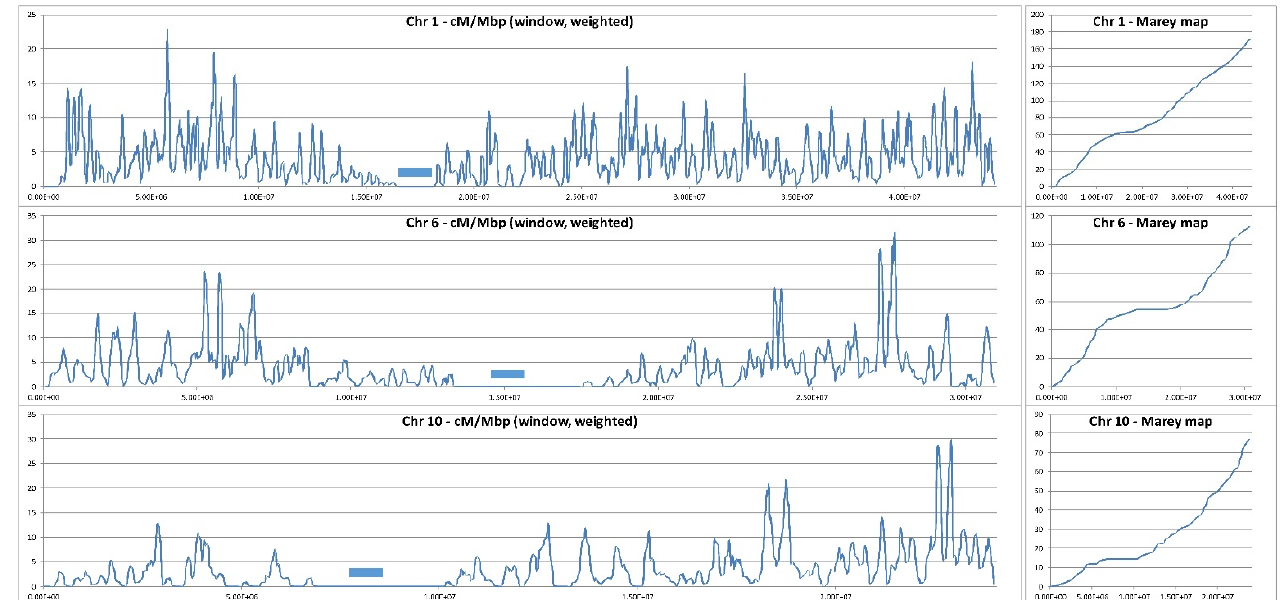
Figure 1. Local recombination rate along three representative chromosomes of rice. Cross-over positions have been deduced from low coverage (4x) Illumina reads of 380 F2 progeny plants derived from selfing of an indica/japonica hybrid. X axis: chromosome coordinates (Kitaake genome) in base pairs. Y axis: local recombination fraction in centiMorgans per megabase (cM/Mb). Blue bars mark centromere positions (Courtesy of Mathias Lorieux, IRD, France).